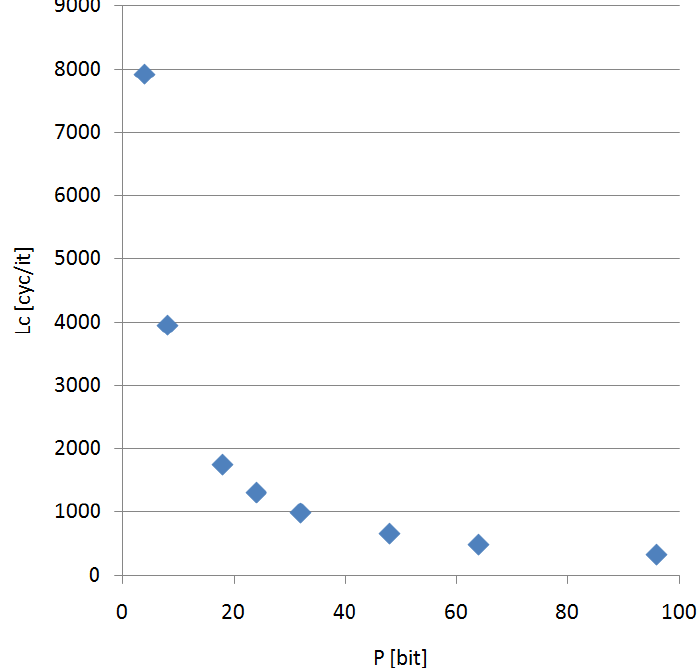
Figure 6. Influence of the P value on the L c value for a QC-LDPC decoder with an architecture based on Token Ring.